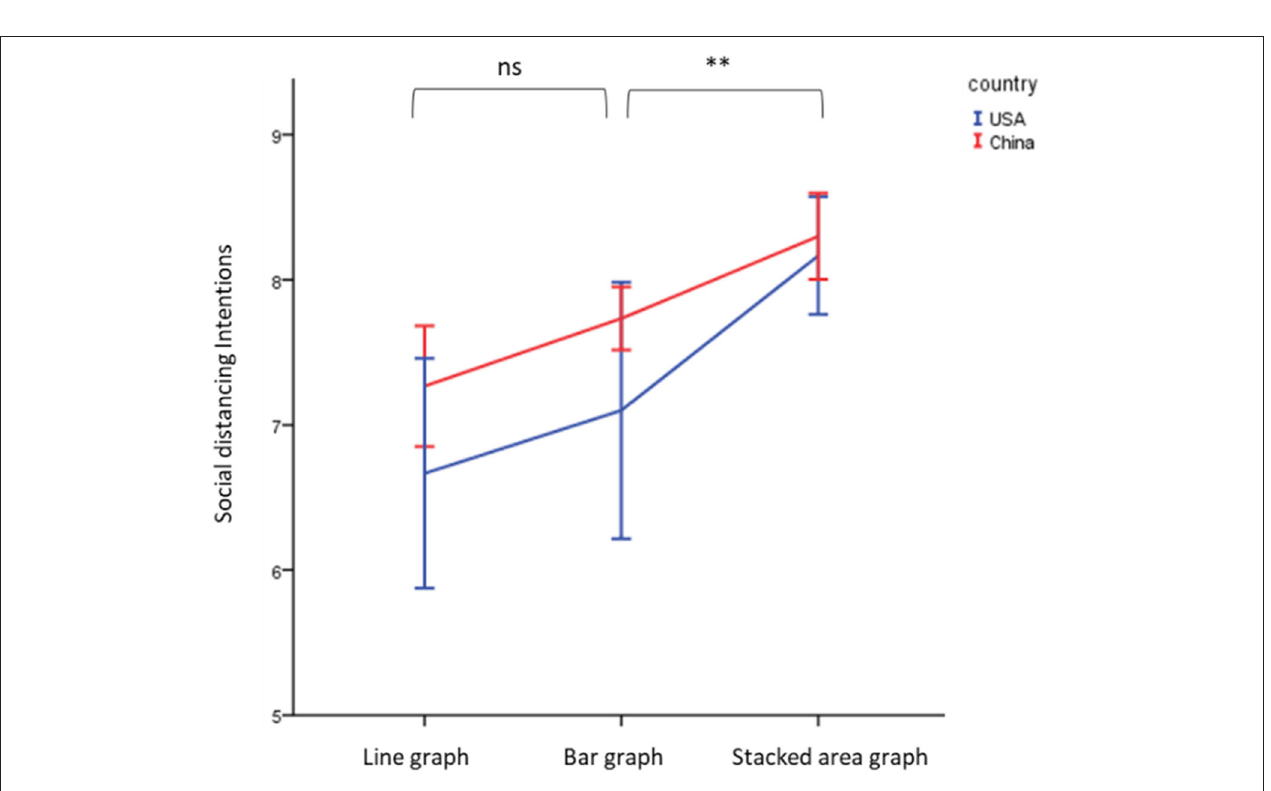
different cultures and graphs [ F (2, 174) = 0.52, p = 0.59]. H4 was not